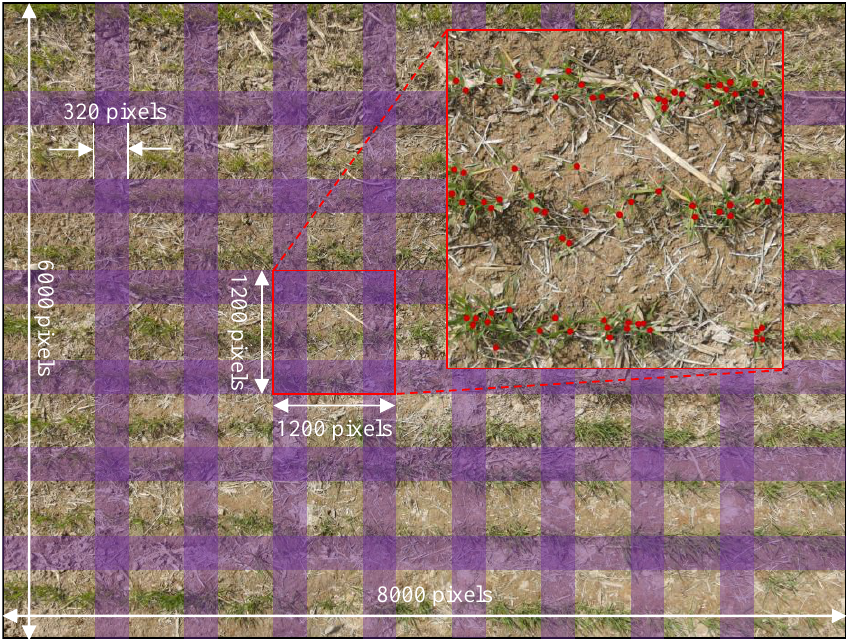
Figure 2. An overview of UAV image splitting with overlay (purple strips). The red box emphasizes an image patch with wheat plants annotated.